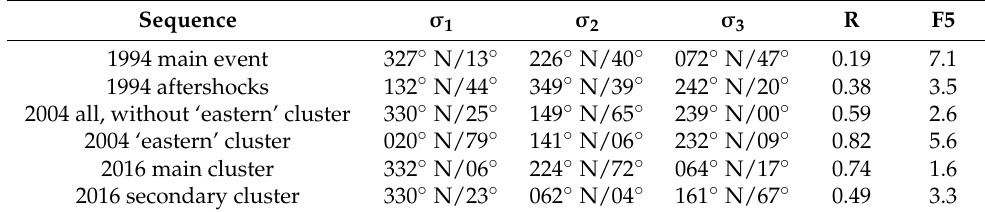
Table 2. Stress regime for the cases considered in Figure